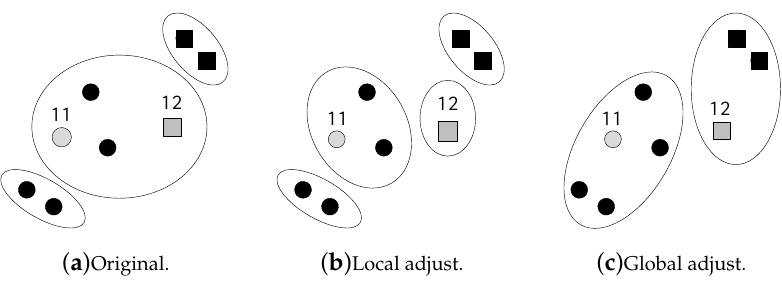
Figure 2. How does the machine adjust the current clustering result? Two strategies are shown. The large circles indicate